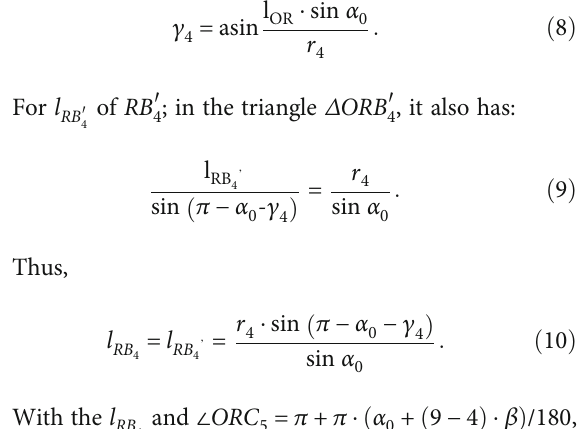
Figure 6: Simpli fi ed model of rock, bottom cutter, and bionic blade. (a) Model with rock, bottom cutter, bionic blade, and PDC teeth. (b) Model with only rock and PDC teeth. Table 2: Material parameters of the PDC teeth. Density (kg/m 3 ) Young ’ s modulus (GPa) Poisson ’ s